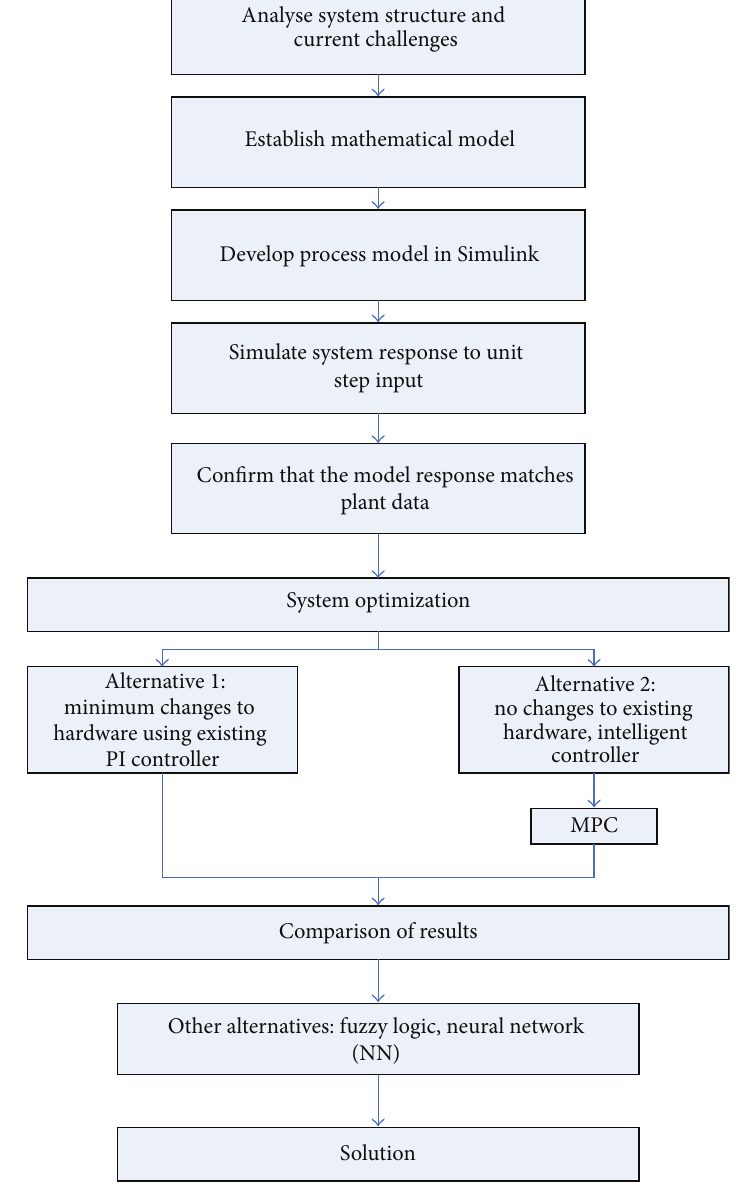
Figure 2: Project task breakdown